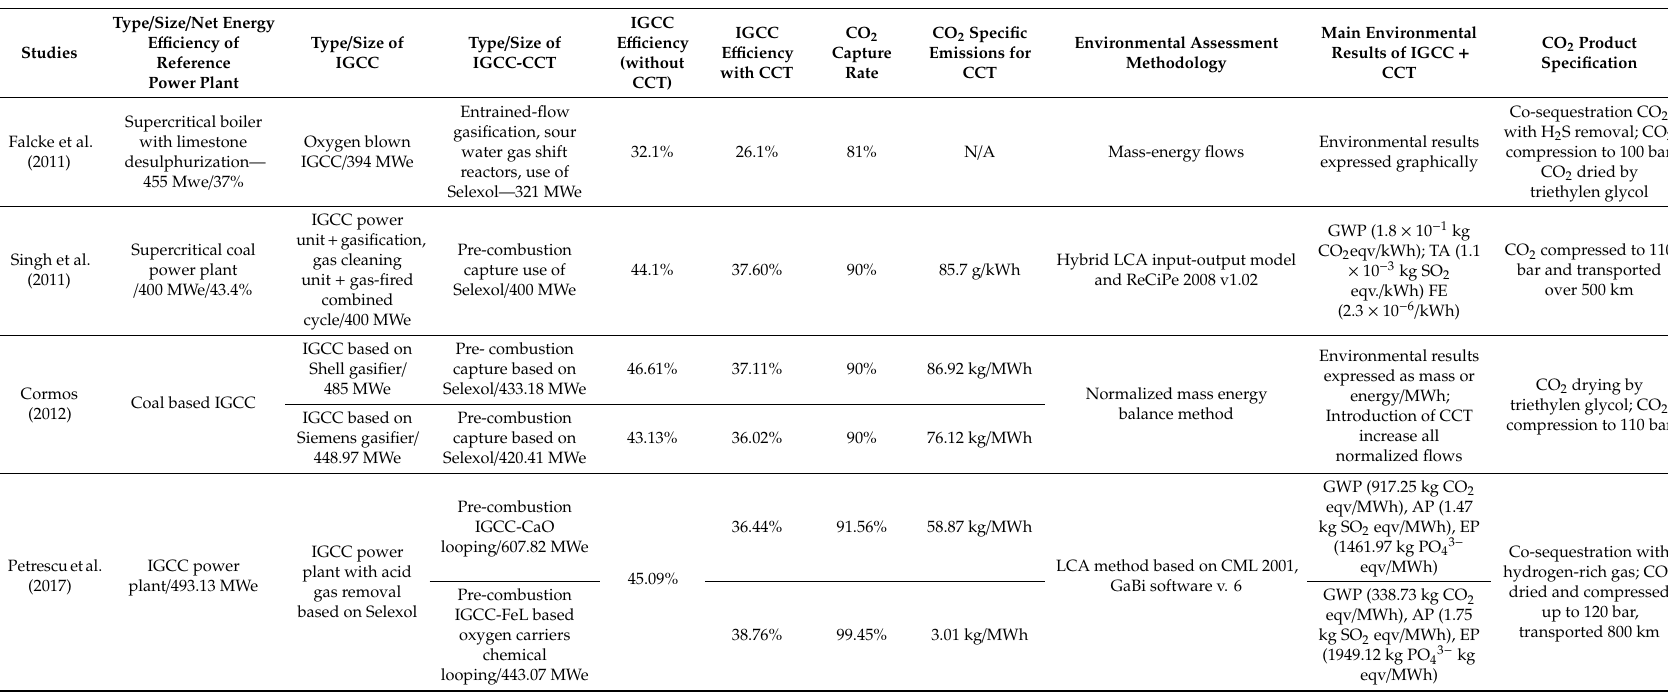
Table 1. Review of references focused on environmental assessment of pre-combustion integrated gasification gas cycle technology with CO 2 capture (IGCC-CCT), global warming potential (GWP), acidification potential (AP), fossils depletion (FD), eutrophication potential (EP), terrestrial acidification (TA), and freshwater eutrophication